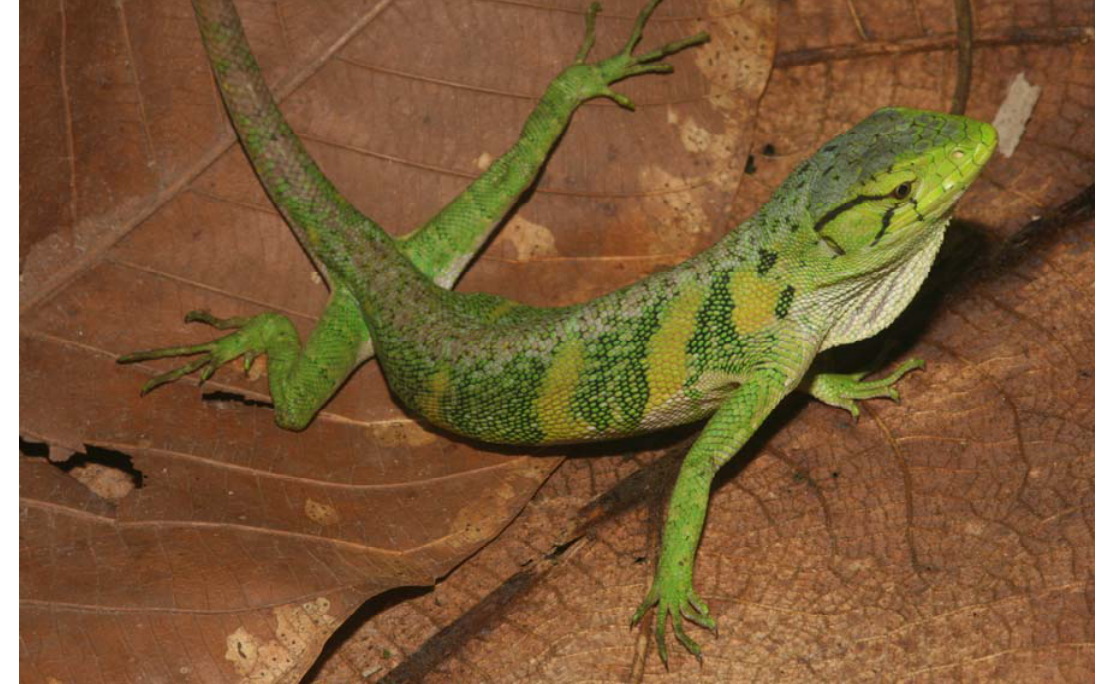
Figure 2 . Adult male P . marmoratus collected in the municipality of Aripuanã. Photo by R. A. K.